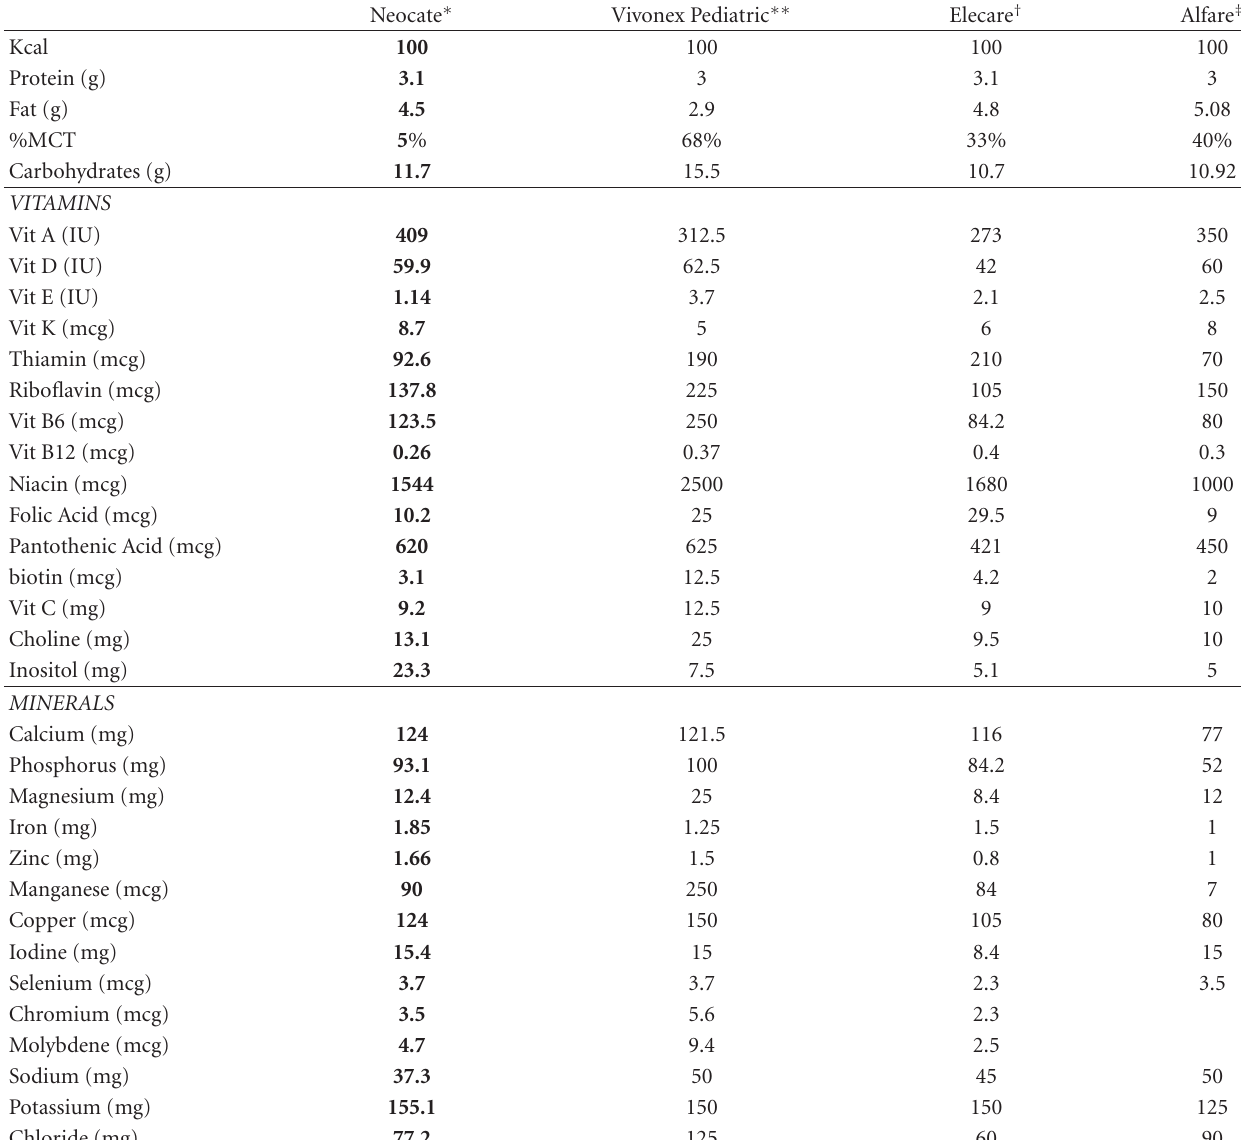
Table 2: Composition of the 3 commercialised elemental infant formulas and the hydrolized formula used in 2/4 patients. ∗